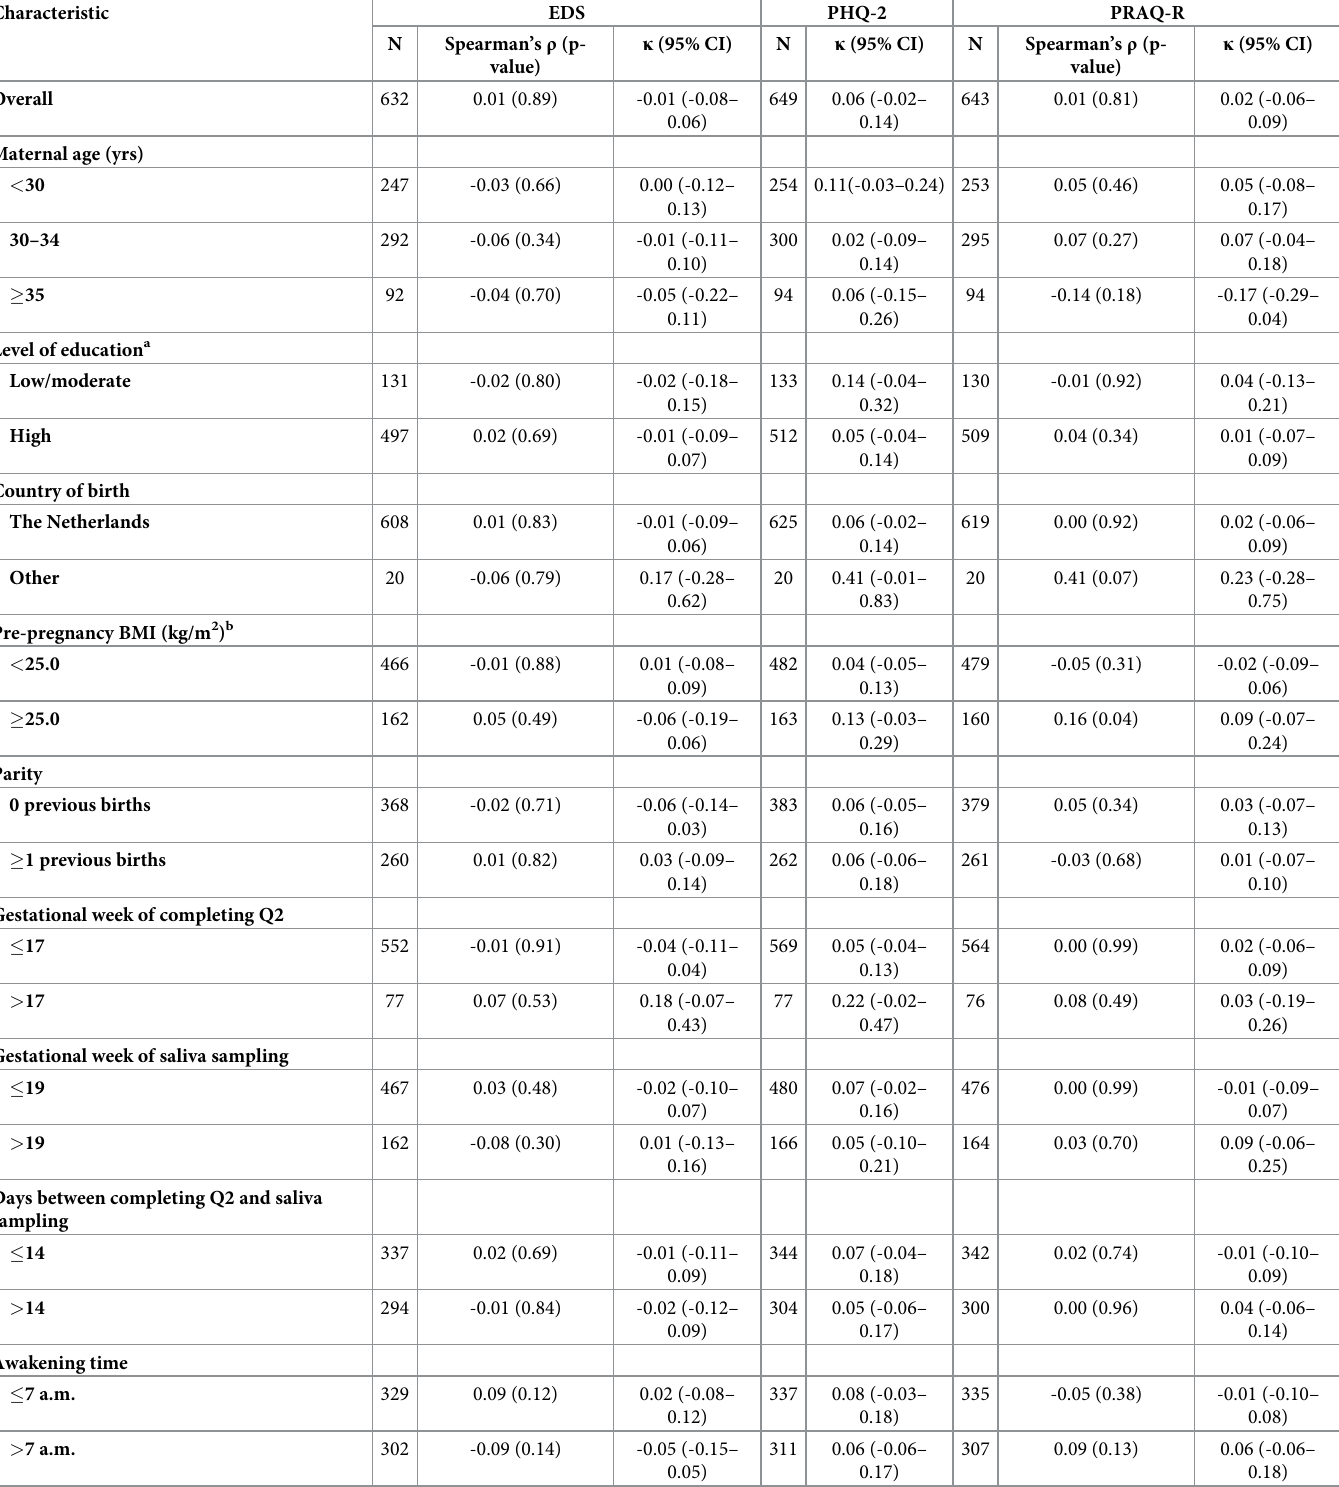
Table 2. Spearman correlation coefficients and Cohen’s Kappas of awakening cortisol levels and EDS, PHQ-2, and PRAQ-R scores. Data from the PRIDE Study,